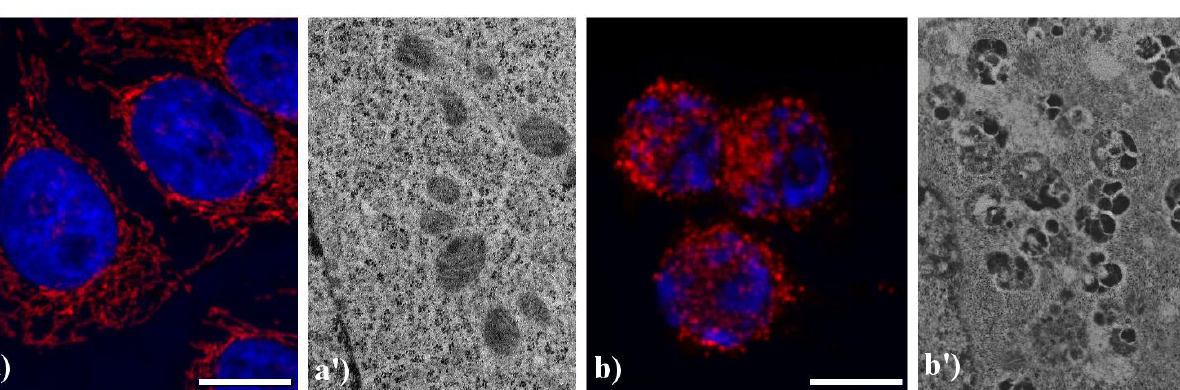
Figure 5. Morphological features of mitochondria. ( a , a' ) control HeLa cells; ( b , b' ) HeLa cells treated with etoposide (40 μM for 20 h). ( a , b ) confocal microscopy of mitochondria immunolabeled with a mouse monoclonal antibody recognizing the mitochondria-specific mtHSP70 (1:50 in PBS; Alexis, Vinci Biochemicals) and then with an Alexa 594-conjugated anti-mouse IgG antibody (1:200 in PBS, red fluorescence; Molecular Probes). DNA was counterstained with Hoechst 33258 (blue fluorescence). Scale bar: 20 μm. ( a' , b' ) electron